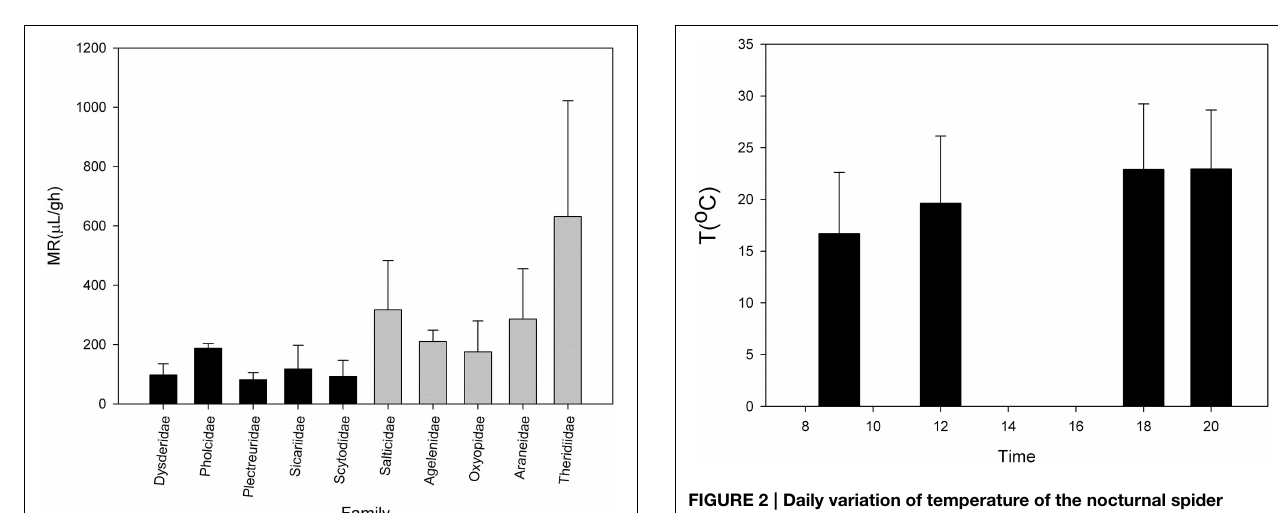
FIGURE 2 | Daily variation of temperature of the nocturnal spider Loxosceles laeta (modified from Alfaro et al.,